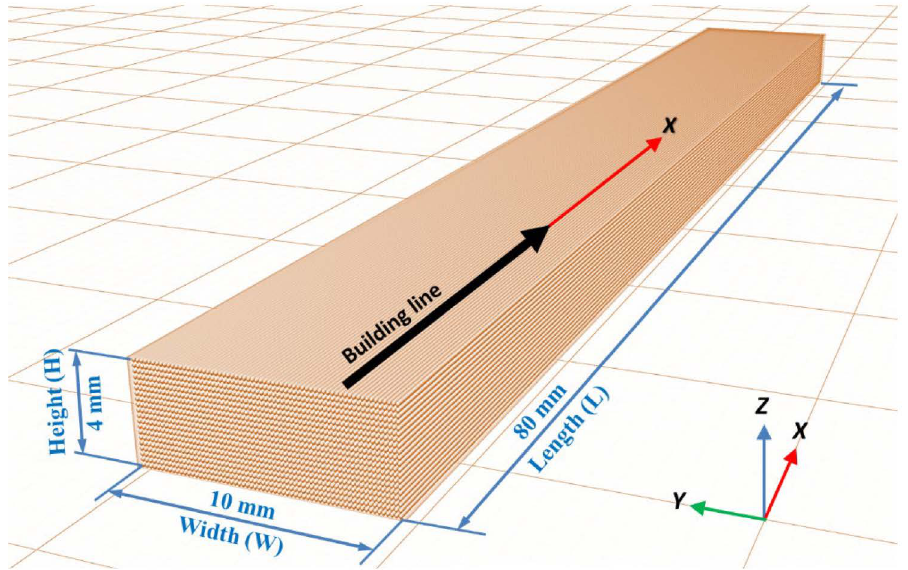
Figure 1. Specimen dimensions and building line